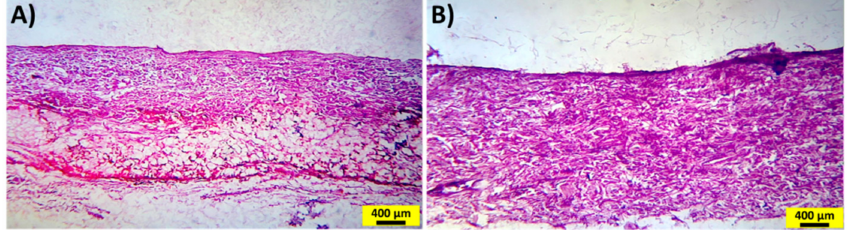
Figure 6. Representative H&E staining assay of rat skin after the IP experiment, except for ( A ) the control, ( B ) applying the current density of 0.13 mA cm − 2 for 48 h. Scale bar = 400 µ